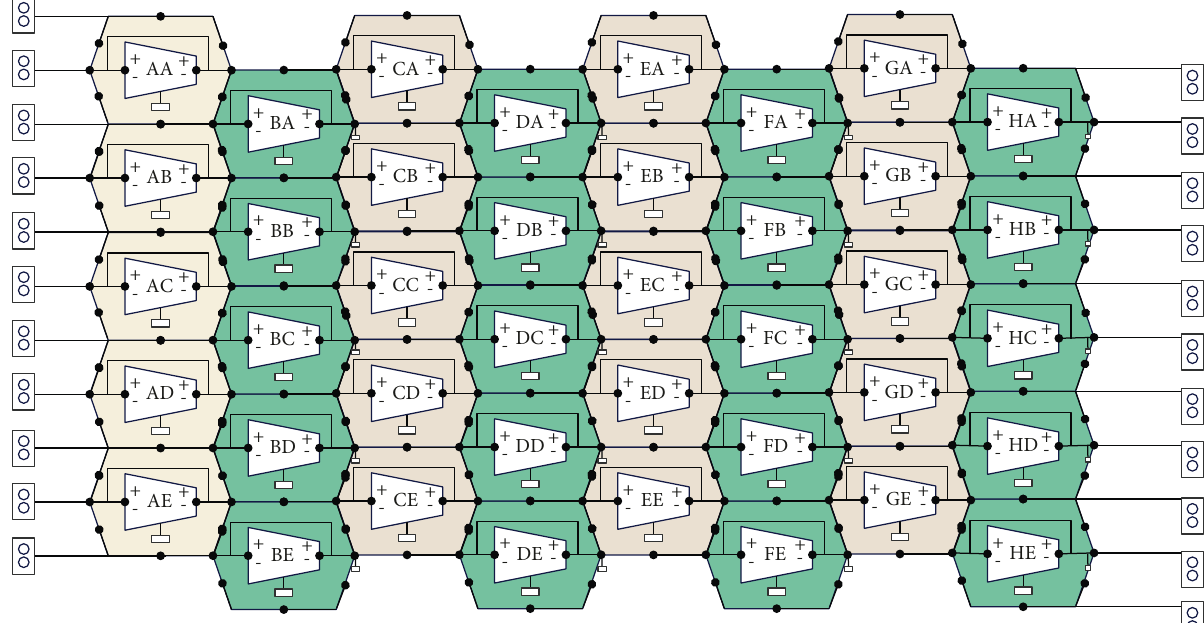
Figure 6: Schematic diagram of 5 × 8 programmable analog array.